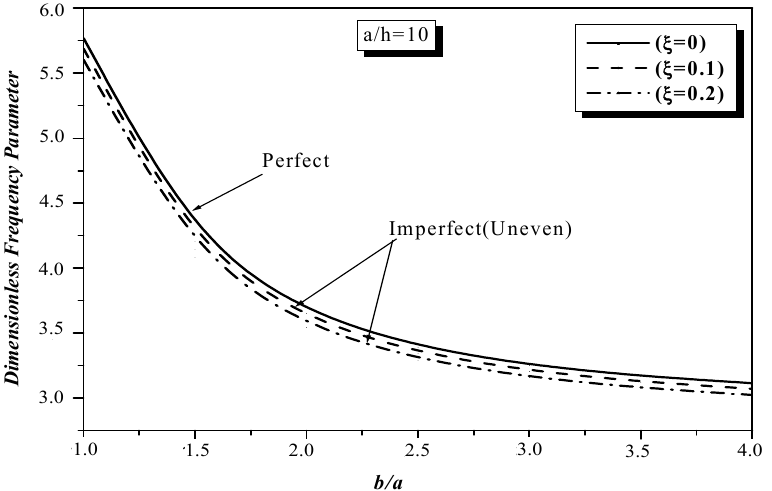
Figure 2. The dimensionless frequency ω vs. the material power index p for FG plates with different porosity factors ( b / a = 1 and a / h = 10 ).